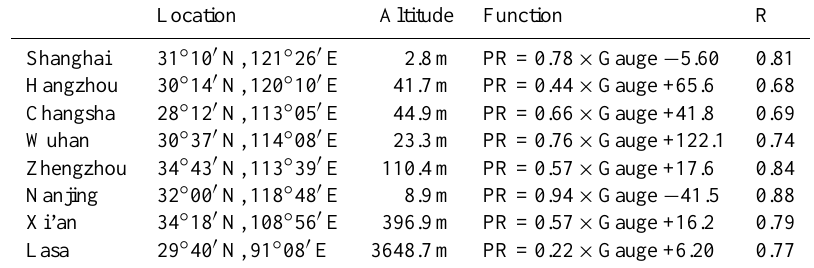
Table 1. The correlation of rain gauge and TRMM PR measured precipitation amount (mm/per season) at various sites over China. Location Altitude